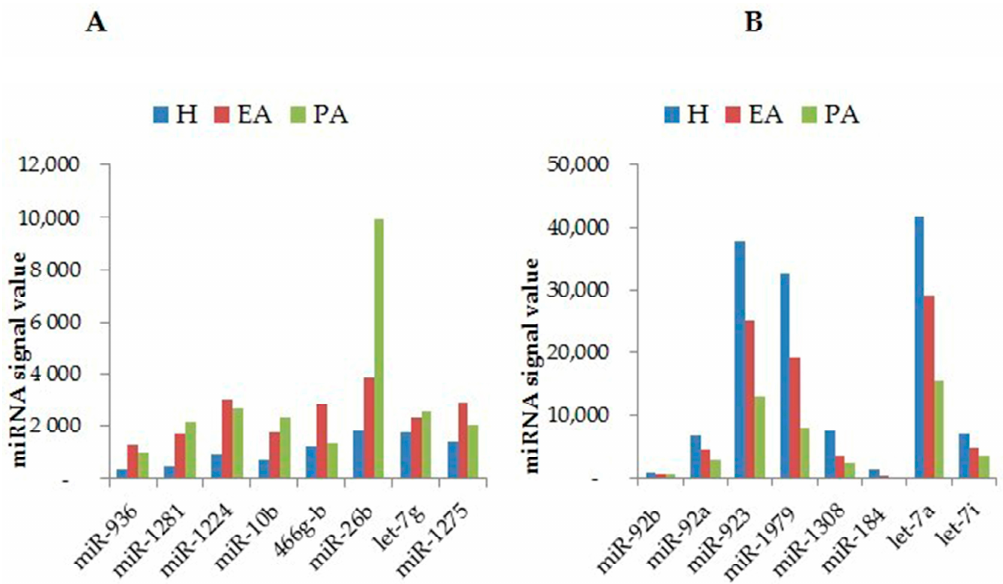
Figure 1. Differential expression of some miRNAs during follicular atresia in pigs. The expression profiles of miRNAs whose expression is upregulated during follicular atresia ( A ); and miRNAs whose expression is downregulated during follicular atresia ( B ) are shown. H, healthy; EA, early atretic; PA, progressively atretic modified from [45,46].